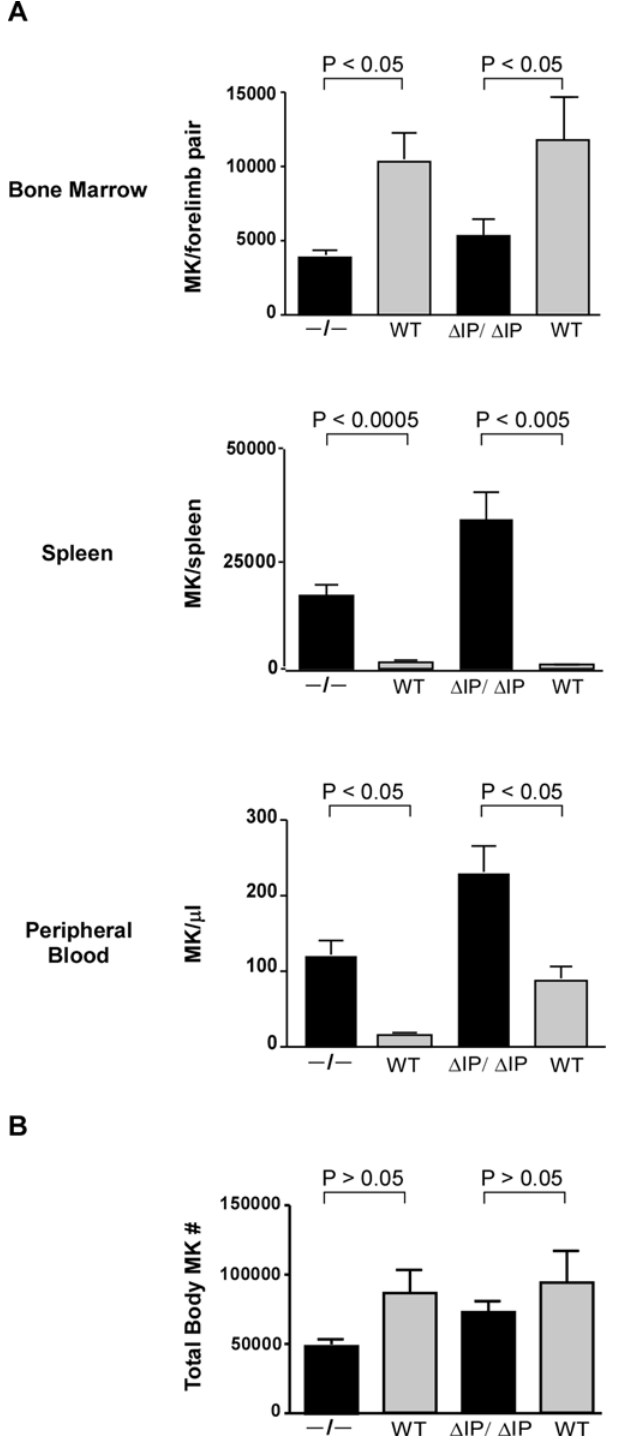
Figure 4. SHIP 2 / 2 MK have lowered CXCR-4 receptor expres- sion. (A) Histogram representing the level of CXCR-4 receptor expression on SHIP 2 / 2 (black line) and WT (gray line) Lin 2 c-kit 2 CD41 + cells in BM. Isotype antibody control indicated in the histogram. (B) Represented is the mean 6 SEM of the mean fluorescence (MFI) intensity of CXCR-4 expression on SHIP 2 / 2 ( 2 / 2 ) (n=4) and WT (n=4) Lin 2 c- kit 2 CD41 + in BM. Significance was established using the Mann-Whitney test. p values indicated in each